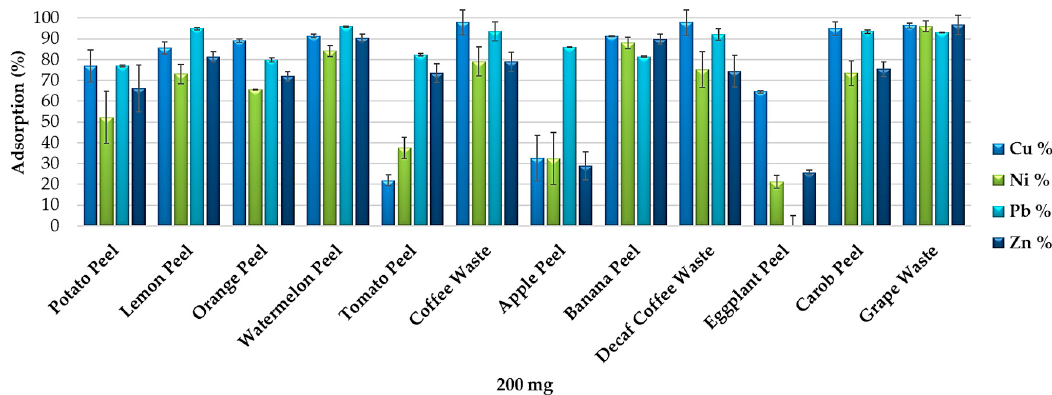
Figure 6. Removal efficiency of the 12 food waste adsorbents (200 mg) from the heavy metal wastewater produced in a hydro-metallurgical process (pH 5.5).